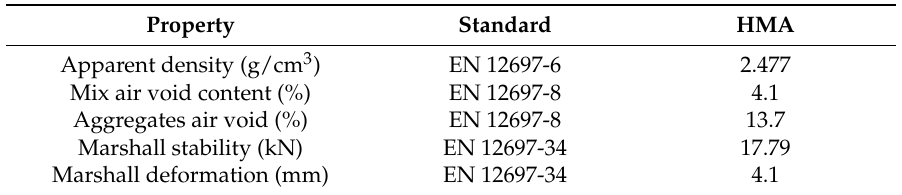
Table 2. Main properties of the asphalt